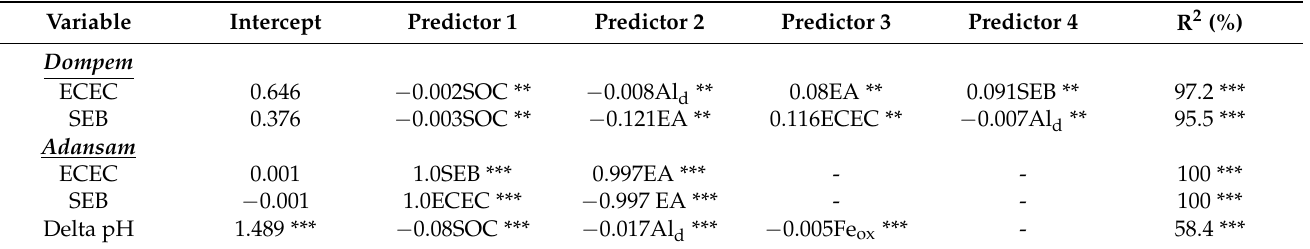
Table 6. Multiple linear regression models (stepwise forward method) between charge properties and other soil properties for each study